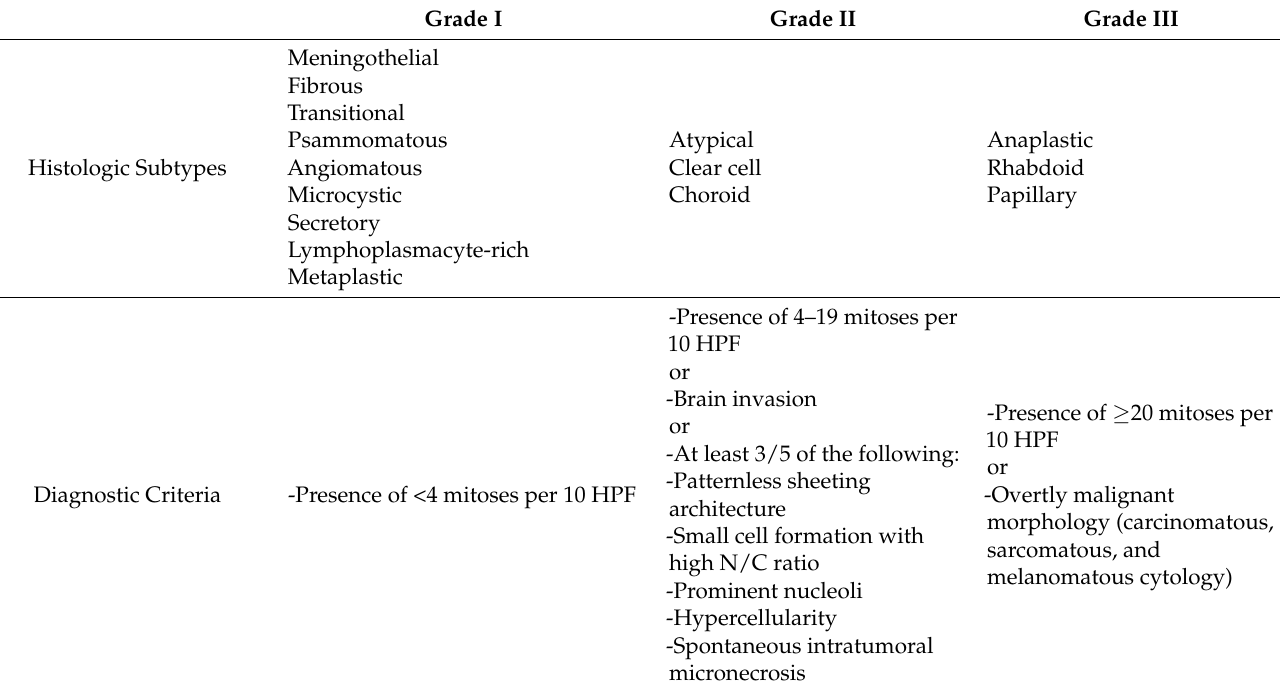
Table 1. Overview of 2016 World Health Organization (WHO) classification system for grading meningiomas. HPF, high-power fields; N/C,